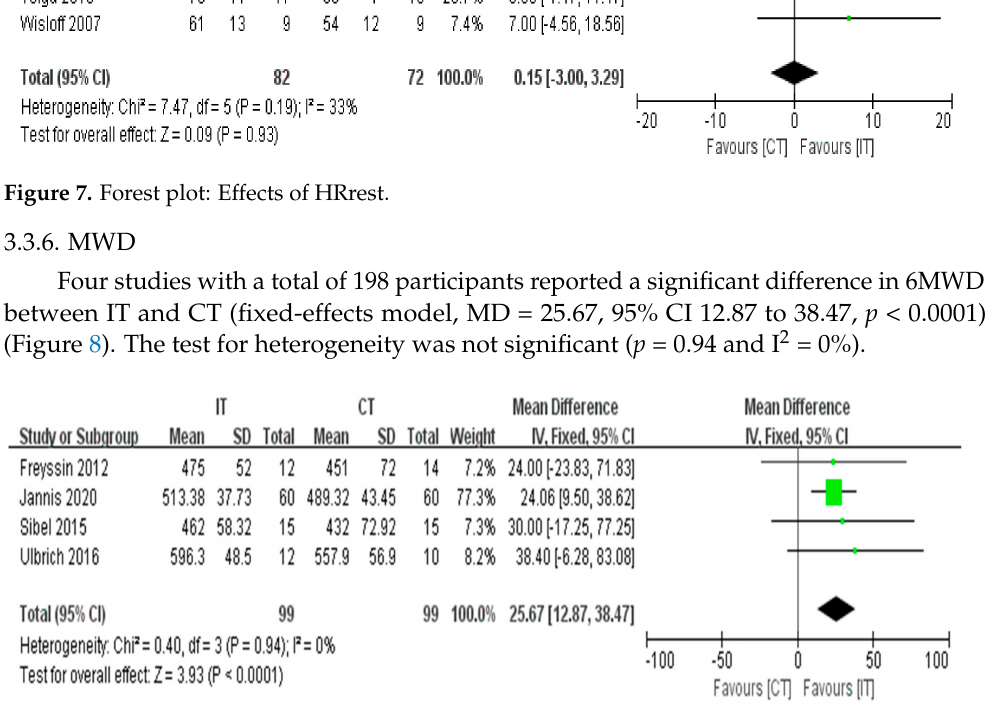
Figure 8. Forest plot: Effects of 6MWD.